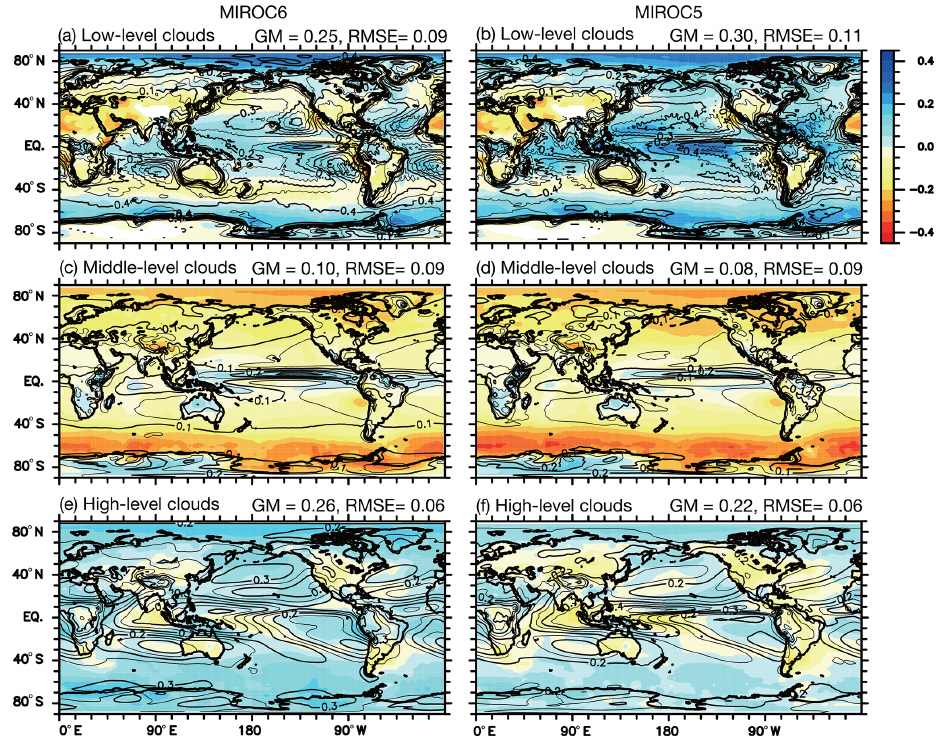
Figure 6. Same as Fig. 4, but for cloud cover in MIROC6 (a, c, e) and MIROC5 (b, d, f) . Low-, middle-, and high-level cloud cover is aligned from the top to the bottom. The tops for low-, middle-, and high-level clouds are defined to exist below the 680hPa, between the 680 and 440hPa, and above the 440hPa pressure levels, respectively. The unit is nondimensional. ISCCP climatology is used as